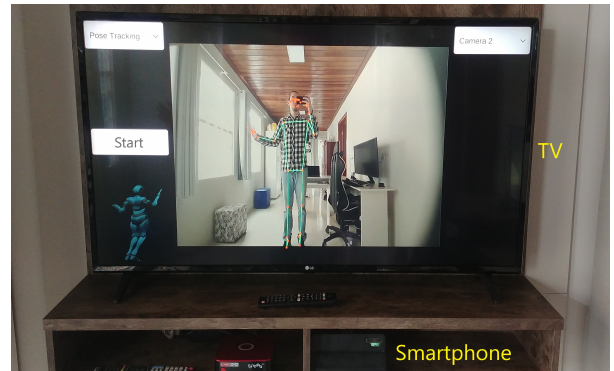
Figure 1. A smartphone is placed below the TV with its camera pointed to the user while its screen is projected to the TV. The movements only last a few seconds, and once the user returns to the starting position, it is considered a complete